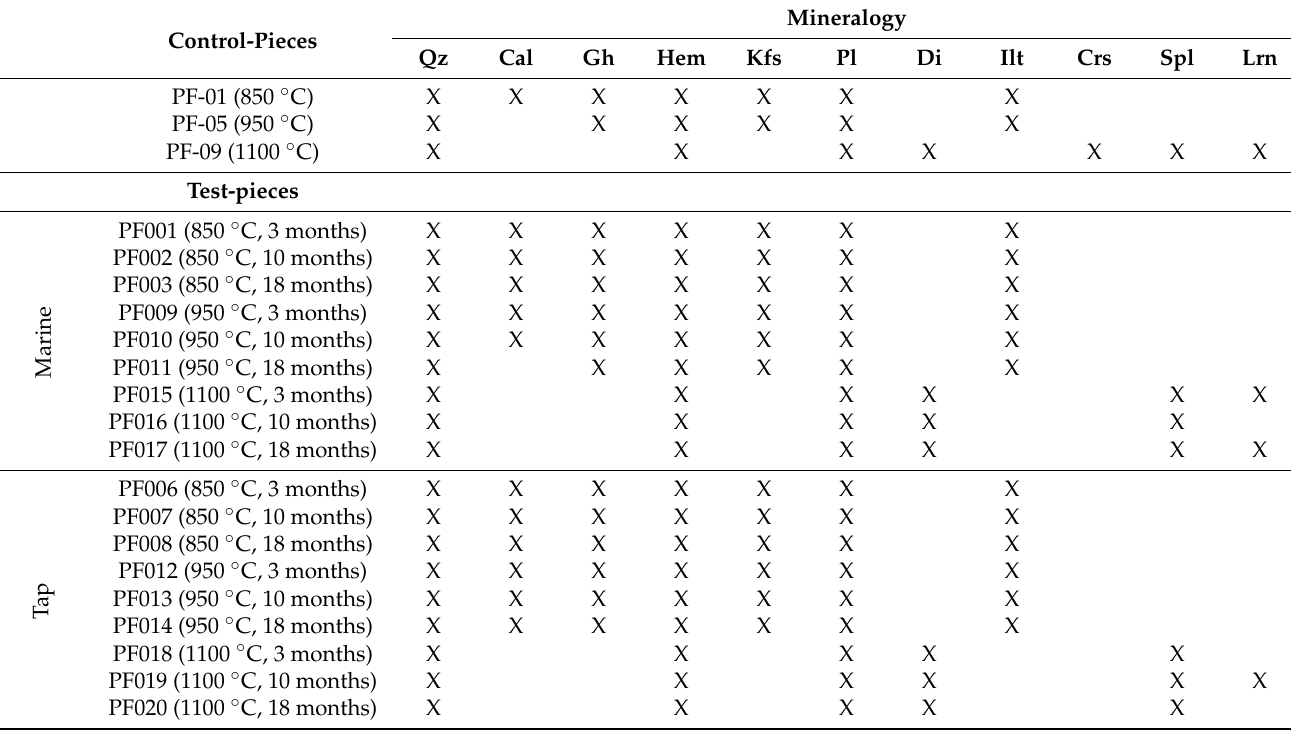
Table 6. Summary of the mineralogical phases of the marine and tap PF test-pieces. Qz = quartz; Cal = calcite; Gh = gehlenite; Hem = hematite; Kfs = potassium feldspar; Pl = plagioclase; Di = diopside; Ilt = illite; Cristobalite = Crs; Spl = spinel; Lrn = larnite, abbreviations according to Whitney and Evans (2010)